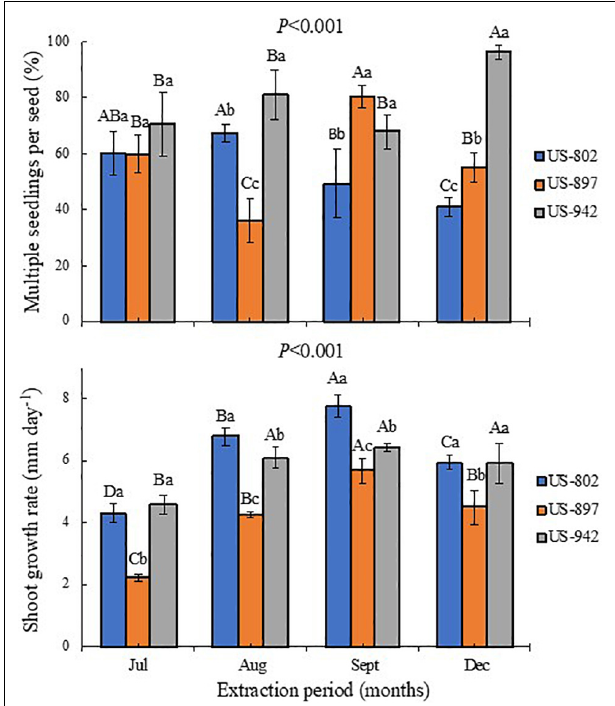
FIGURE 5 | Percentage of multiple seedlings per seed and shoot growth rate of three citrus rootstocks during different period of seed extraction at the Southwest Florida Research and Education Center, Immokalee, FL, United States. Bars followed by the same lowercase and capital letter do not significantly differ in regard to rootstock and seed extraction period, respectively, according to the Tukey’s test ( P ≤ 0.05).